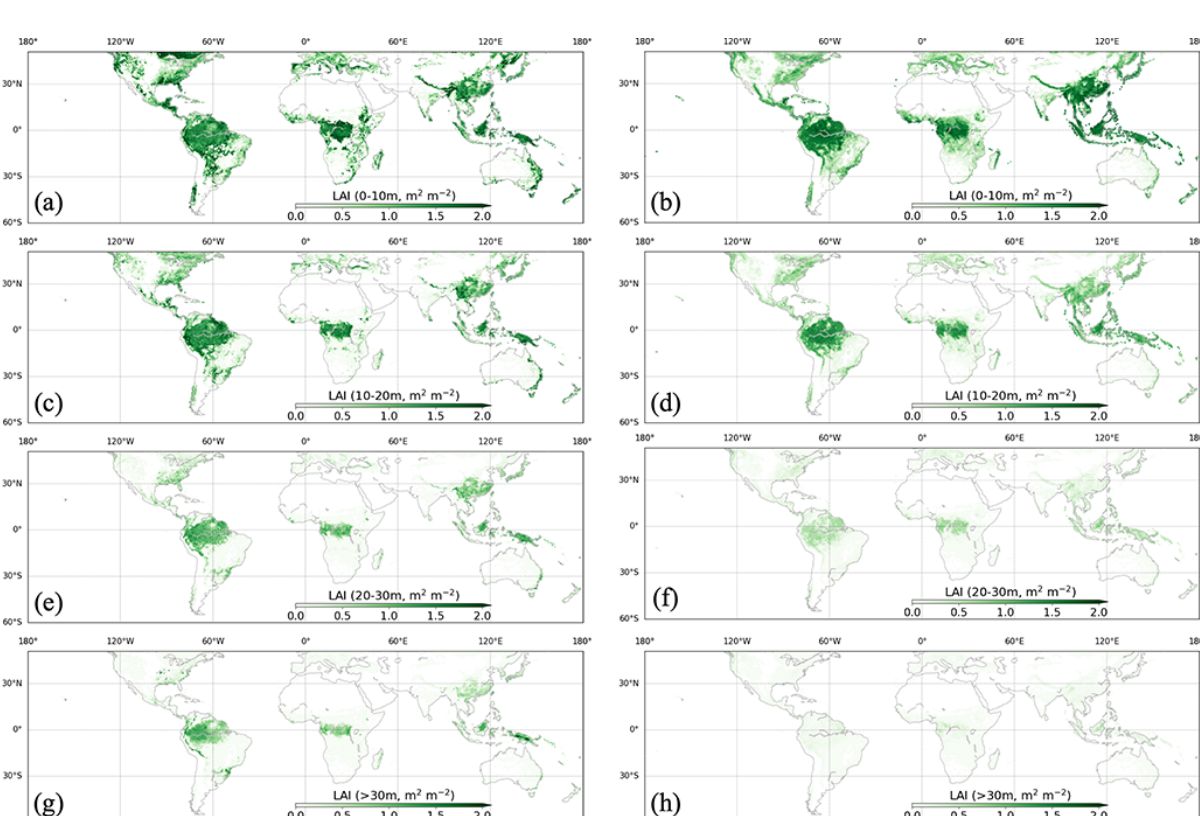
Figure 15. Vertical LAI from ED (left column) and GEDI L2B (right column) at heights of 0–10m in (a) and (b) , 10–20m in (c) and (d) , 20–30m in (e) and (f) , and above 30m in (g) and (h)